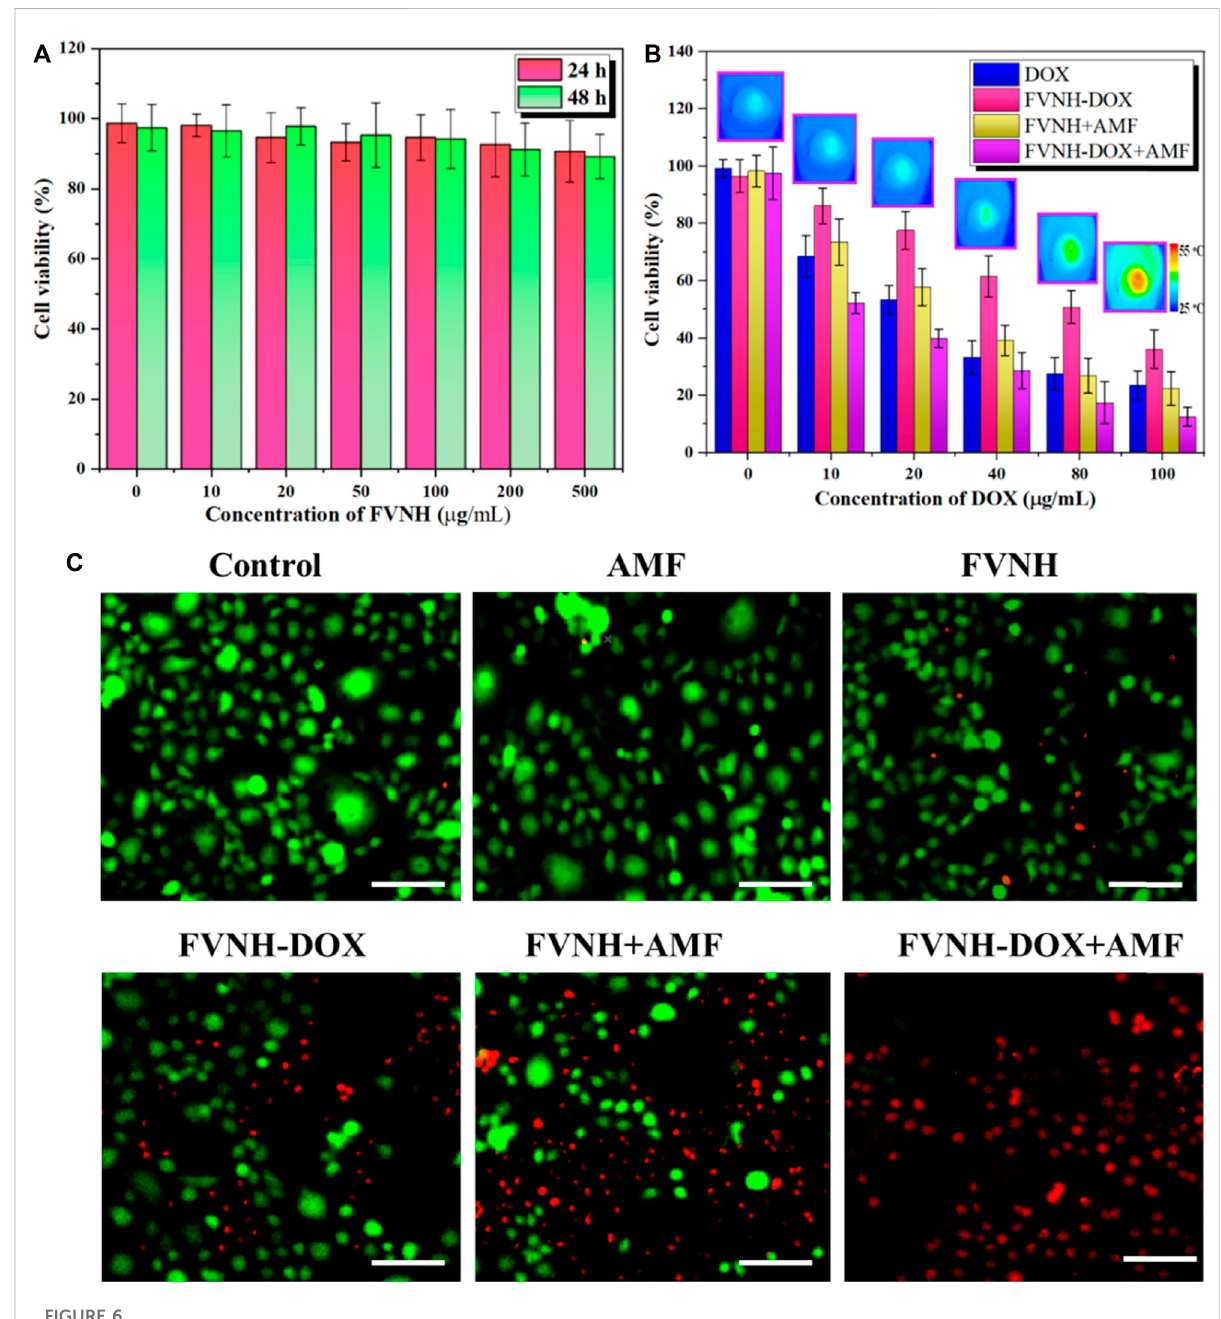
FIGURE 6 Cell viability assay. (A) Cell viability after incubation with different FVNH for 24 and 48 h. (B) Cell viability upon various kinds of treatments at differentconcentrations of DOX and representive thermal images of FVNH-DOX + AMF group. (C) Fluorescence images of co-stainedwith calcein- AM (green) and PI (red) 4T1 cells after different therapies. ( n = 3, mean ± SD), (Scale bar = 100 μ